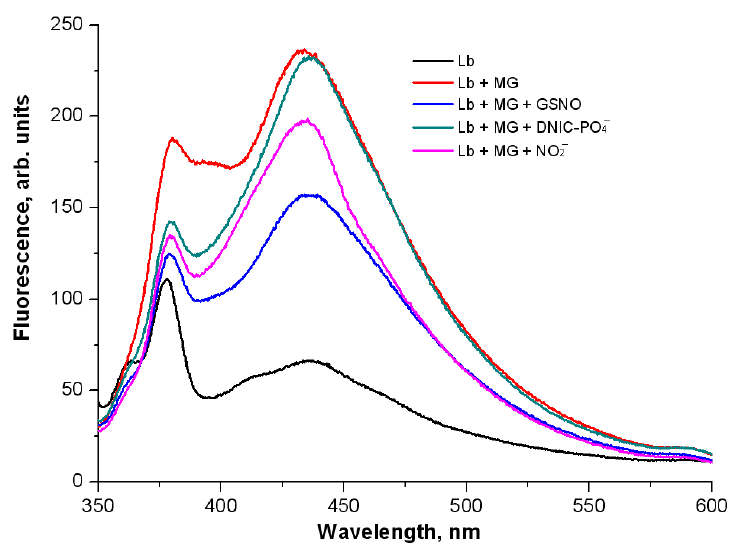
Figure 9. The effect of • NO-derived metabolites on the formation of fluorescent products of non- enzymatic Lb glycation with MG. Reaction mixture: 0.1 mM metLb in 25 mM PBS (pH 7.4), 8 mM MG, and 2 mM of • NO-derived metabolites (GSNO, DNIC-PO 4 − , NaNO 2 − ).